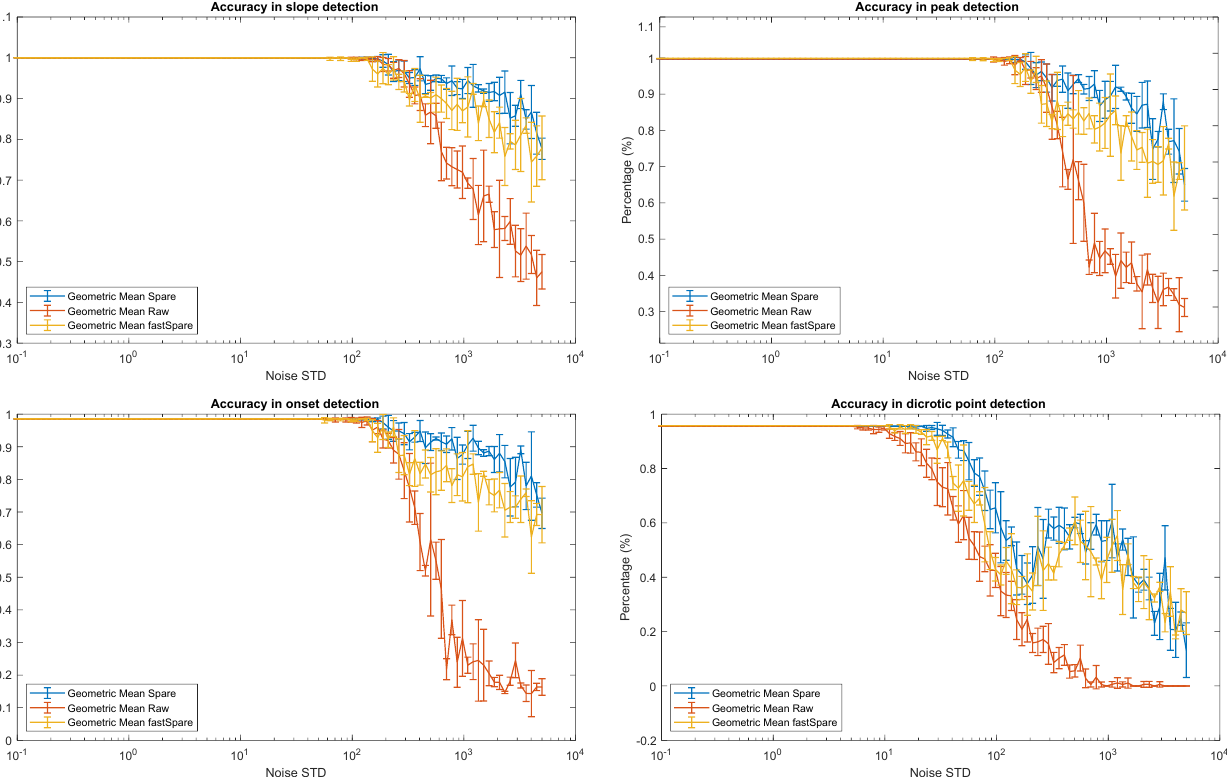
Figure 9. Average and standard deviation of geometric mean between sensitivity and specificity for the detection of slope, peak, onset, and dicrotic points at different noise levels with SPARE (blue line), fastSPARE (yellow line), and raw data (orange line). All experiments were run for five random seeds each (for noise